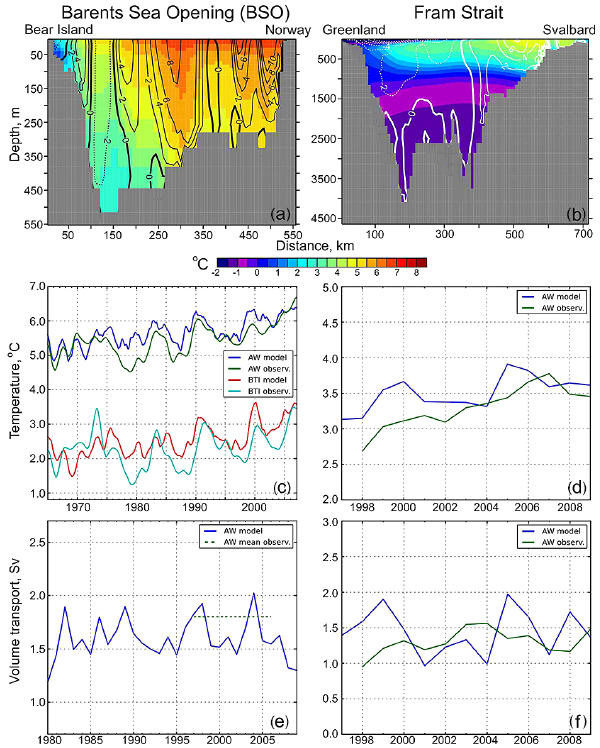
Figure 3. Simulated and observed characteristics of the AW inflow into the Arctic Ocean through the (left) Barents Sea Opening from Bear Island to Norway (BSO) and (right) Fram Strait. The first row shows the simulated mean temperature (in color) and veloc- ity (contour lines) in (a) the Fram Strait from 2002 to 2008, as in Beszczynska-Moeller et al. (2012) and (b) the BSO from 2003 to 2005, as in Skagseth (2008). Positive velocities in (a) and (b) are to the east and north, respectively. (c) Temperature in the AW layer (blue – model, green – observations) defined as the mean between 72–73 ◦ N and 50–200m and in the outflow water in the Bear Island Trough (red – model, cyan – observations) at 73.5 ◦ N, defined as the mean from 300 to 450m. Definitions and observational data are from Skagseth (2008). (d) The AW mean temperature in the core of the West Spitsbergen Current (WSC) from the model (blue) and observations (green), defined as waters with T >2 ◦ C between and 8 ◦ 40 0 E. Definition and observational data are from Beszczynska- Moeller et al. (2012). (e) The AW (defined as T >3 ◦ C) volume transport through the BSO as simulated by the model (blue) with the 1997–2006 mean from observations (green) superimposed (Sk- agseth et al., 2008). (f) The AW volume transport in the WSC (AW defined as in d ), from the model (blue) and observations (green) by Beszczynska-Moeller et al. (2012).